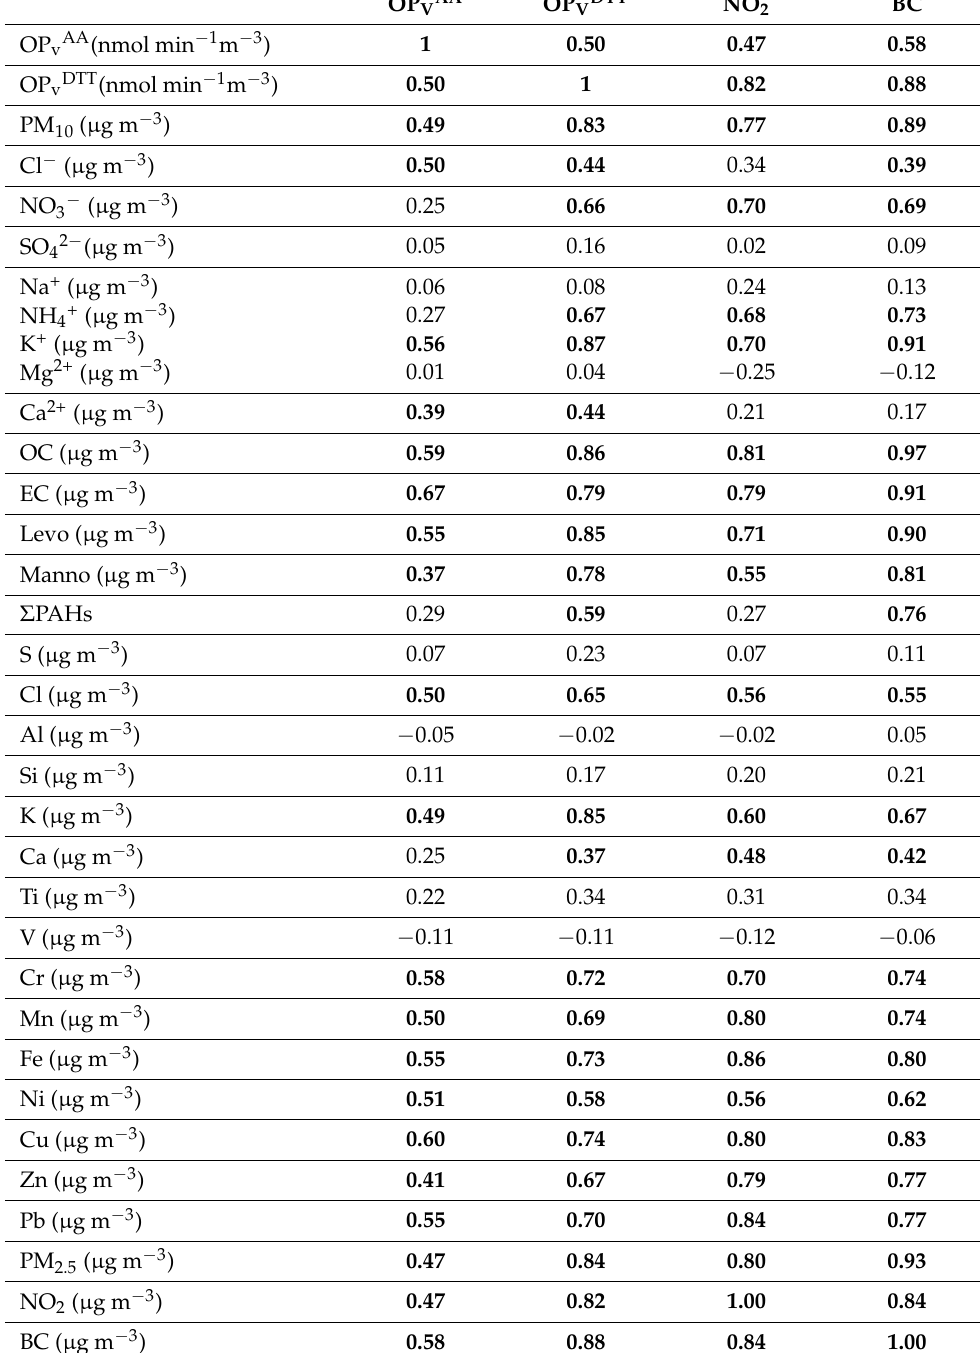
Table 2. Association of the OP AA V and OP DTT V responses and air concentrations of NO 2 and BC with the concentrations of PM 10 chemical components. Pearson’s correlation coefficients (r) computed for the whole study period. Bold values indicate significant correlation at p ≤ 0.01 level. OP